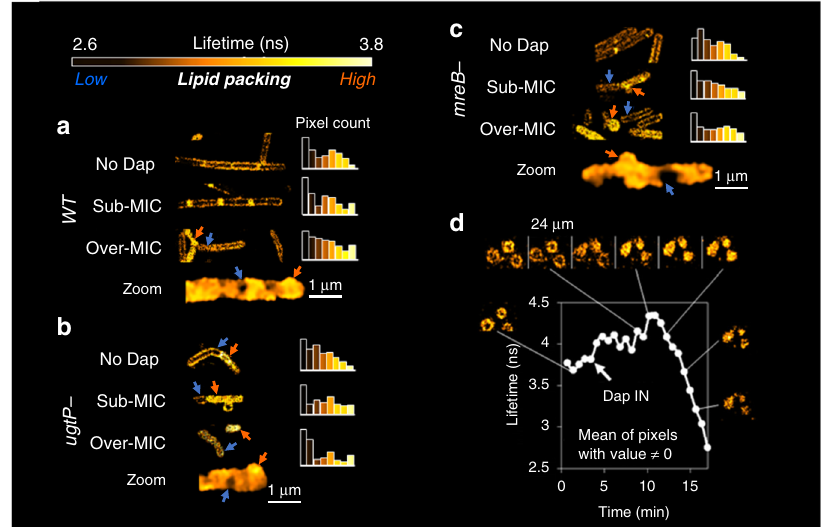
Fig. 2 Dap action on B. subtilis strains (WT, Δ mreB and Δ ugtP strains) and POPG vesicles by the FliptR lipid packing probe. FliptR signal: lower lifetimes correlate to lower lipid packings and vice versa. a FliptR image on WT cells: in the absence of Dap, all the cells keep the same distribution, the bacterial poles display higher packing levels than the bacterial sides, a bimodal distribution of lipid packing values appears; at sub-MIC, at the poles, lipid packing level rises; at over-MIC, an inter-cell heterogeneity appears, certain cells show high lipid packing disseminated over the full cell (orange arrow) while others maintain their previous packing distribution (blue arrow), the distribution of packing stretches and a little peak at higher levels of packing becomes apparent. At higher magni fi cation (zoom) also heterogeneity at the intra-cell level becomes evident, zones of high (orange arrow) and low (blue arrow) lipid packing disseminate inside the cell, in agreement with previous observations 19 . It is observed that the deformations protruding from the cells present higher levels of lipid packing than the zones that do not protrude. b , c For the Δ mreB and Δ ugtP mutants, FliptR signals are akin to WT strain. Yet, the inter- cell heterogeneity appears at lower Dap concentration, sub-MIC instead of over-MIC, supporting that ‘ healthier ’ bacterial cell wall limits the deformations induced by Dap. d Tracking of the progression of the lipid packing on POPG vesicles exposed to over-MIC Dap by FliptR. Dap is injected at the ‘ Dap IN ’ label and a two-step process takes place. First the vesicles rigidify, then they collapse and the lipid packing is drastically reduced to values below the initial ones. This two-step process could explain the two zones of low and high lipid packing identi fi ed in the bacteria cells exposed to showing tighter lipid acyl chain packing at the poles and looser packing at the sides. In the WT cells, low concentrations of Dap seem to slightly increase packing at the poles. However, higher Dap concentrations increase the heterogeneity in the distribution: We observe tight lipid packing over the totality of some cells (Fig. 2a, WT, over-MIC, orange arrow), while others maintain the loose packing found in the absence of Dap (Fig. 2a, WT, over- MIC, blue arrow); as a result the packing distribution is no longer bimodal but stretched and with a little peak at higher levels of packing. Furthermore, not only there is a heterogeneity between cells but the intra-cellular heterogeneity also increases. The Dap induced deformations of the membranes are heterogeneous and result in zones of high and low lipid packing with higher levels of lipid packing at the protrusions (Fig. 2a, WT, over-MIC, zoom, orange and blue arrows). Similar observations were made by Müller et al. in 2016 using the hydration of the Laurdan